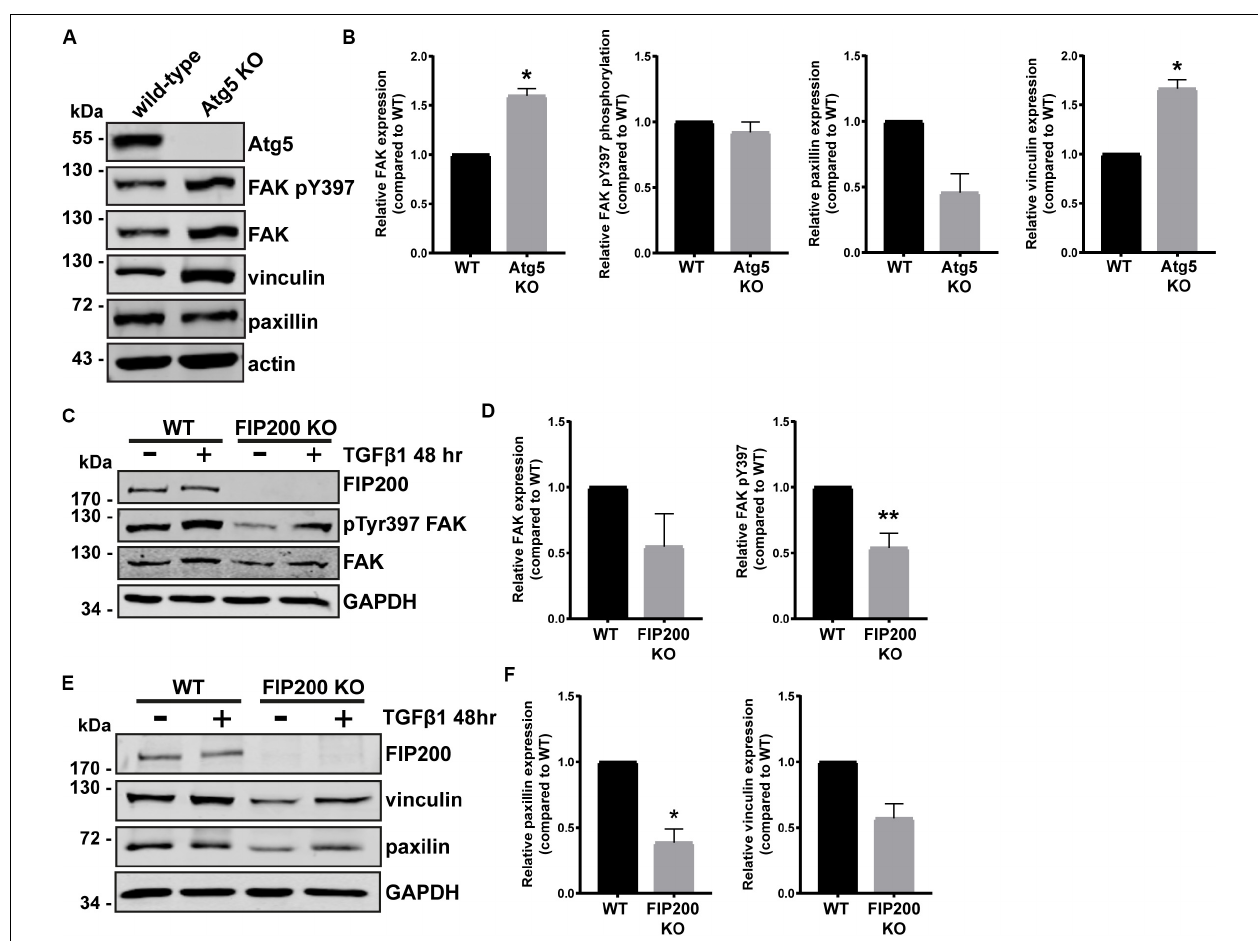
FIGURE 5 | FIP200 or Atg5 depletion has a differential impact on focal adhesion composition. (A) Western blot analysis of lysates harvested from MCF10A wild-type and Atg5 KO cells cultured in normal growth media. Immunoblotting performed on indicated proteins. (B) Quantitation of relative FAK, FAK pY397, paxillin, and vinculin levels. Graphs represent levels compared to wild-type and are comprised of at least 3 independent experiments. (C) Western blot analysis of lysates harvested from MCF10A wild-type and FIP200 KO cells either untreated or treated with 5 ng/ml TGF β 1 in normal growth media for 48 hours. Immunoblotting was performed against the indicated proteins. (D) Quantitation of relative FAK and FAK pY397 levels. Graphs represent levels compared to wild-type and are comprised of at least 3 independent experiments. (E) Western blot analysis of lysates harvested from MCF10A wild-type and FIP200 KO cells either untreated or treated with 5 ng/ml TGF β 1 in normal growth media for 48 hours. Immunoblotting was performed against the indicated proteins. (F) Quantitation of relative paxillin and vinculin expression was performed. Graphs represent levels compared to wild-type and are comprised of at least 3 independent experiments. * p < 0.05, ** p <